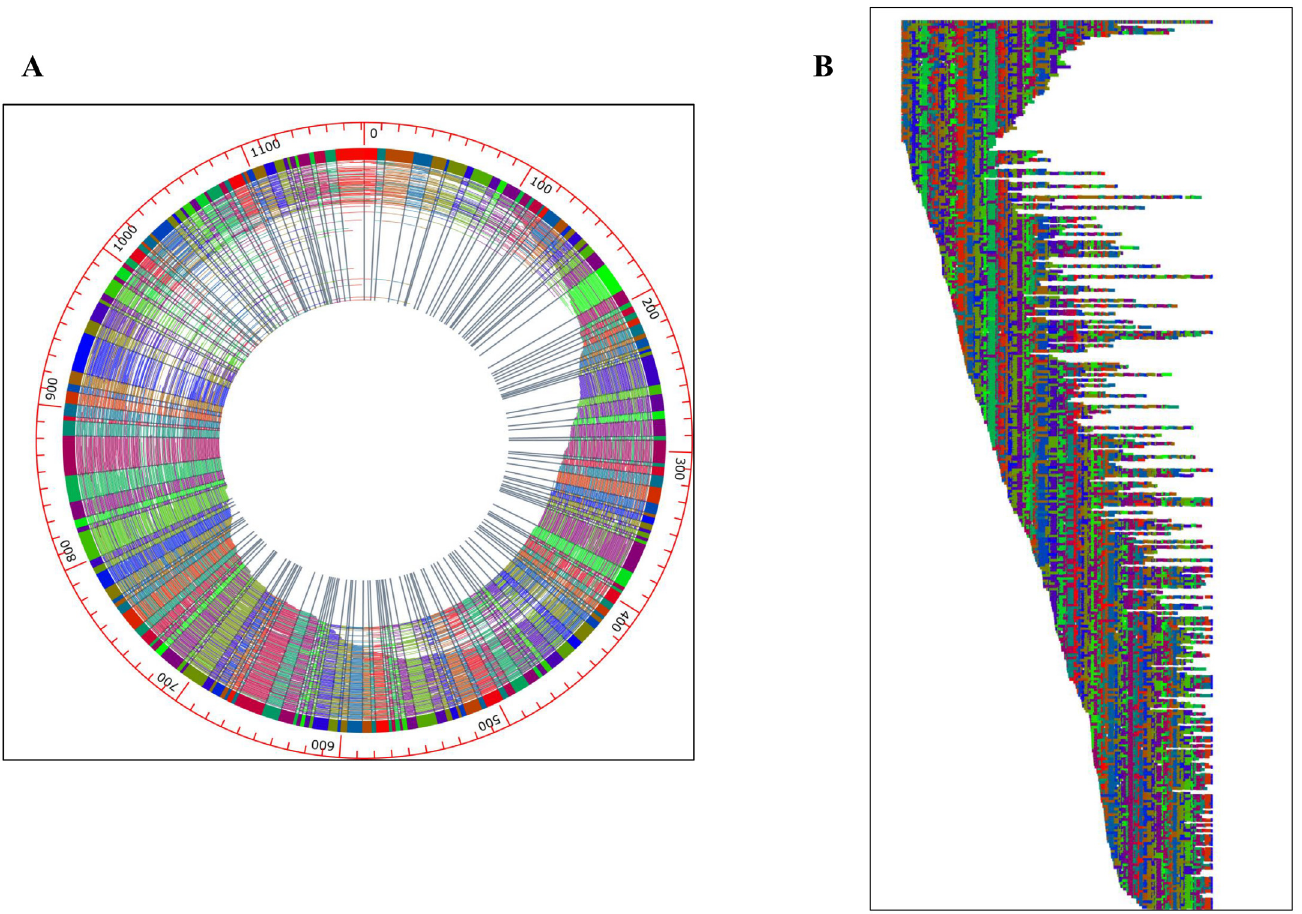
Fig 2. Optical maps of R . opacus strain M213 showing the presence of a circular megaplasmid (A) and a linear extrachromosomal element (B), respectively.